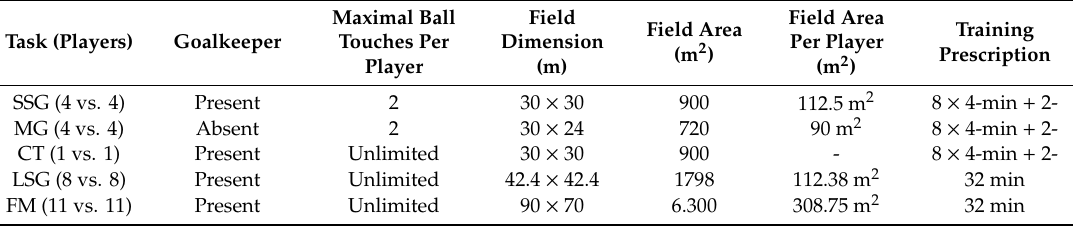
Table 1. On-field integrated training routines included.